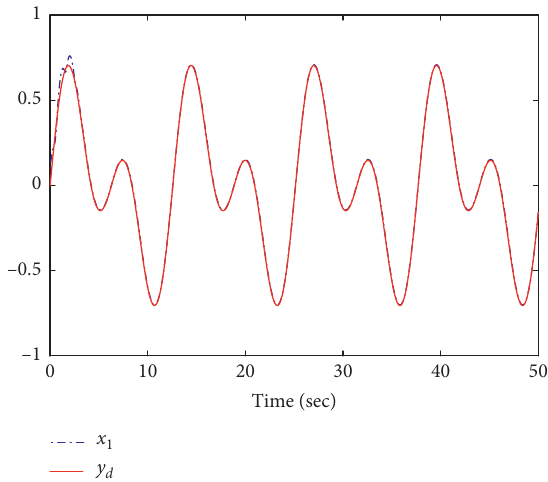
Figure 1: Reference signal y